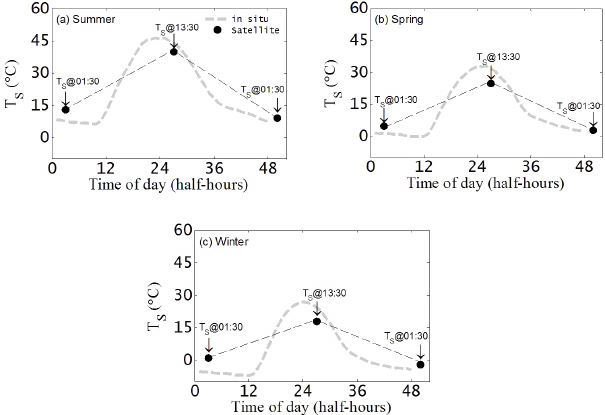
Figure 2. Illustrative examples of in situ monthly diurnal surface temperature ( T S ) and the saw-tooth pattern of monthly satellite midday (13:30LT) to night-time (01:30LT) T S (as hypothesised in Eq. 10) for three different seasons of a year. This shows a linear rise and fall of day–night T S (dotted black line) or vice versa and indi- cates (cid:49)T S symmetry. This also shows how well the two T S samples capture the dynamic range of the day and hence the discretisation is representative of the daily energy balance. The examples in Fig. 2 are shown with half-hourly